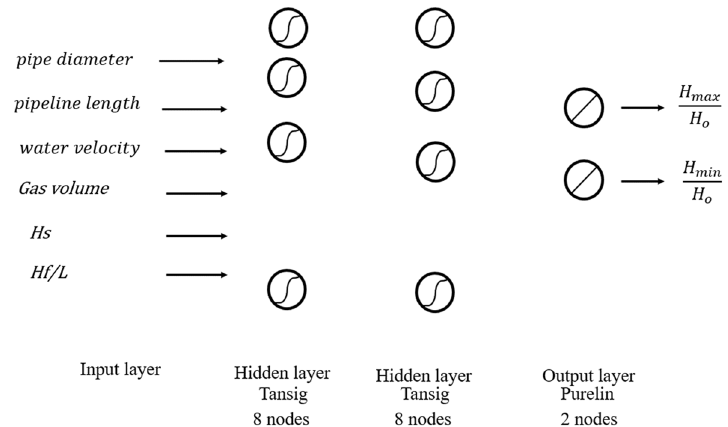
Fig. 6 Structure of the 2nd neural network. The nodes of the hidden layers have a tan-sigmoid transfer function, while the nodes of the output layer have a linear transfer